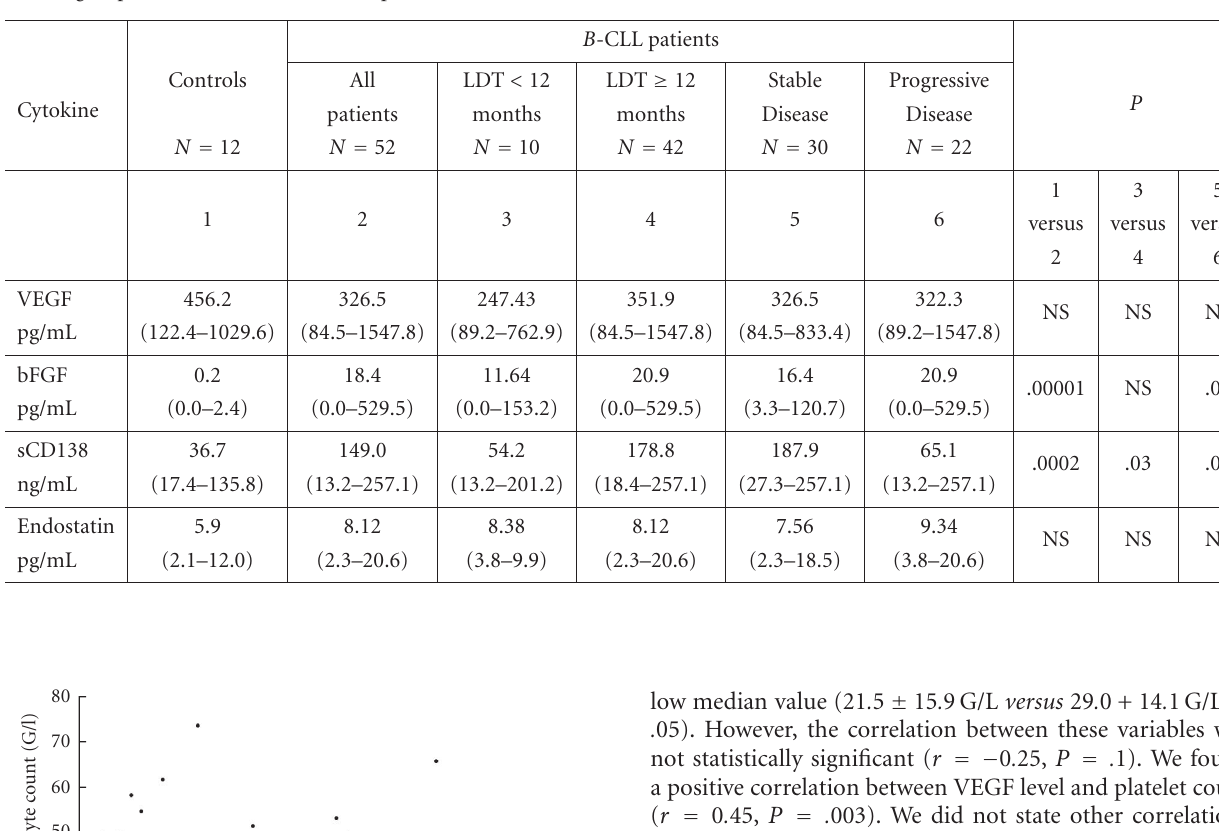
Table 1: Comparison of serum levels (median, minimal, and maximal values) of VEGF, bFGF, syndecan 1, and endostatin in the healthy control group and in 52 untreated B -CLL patients.